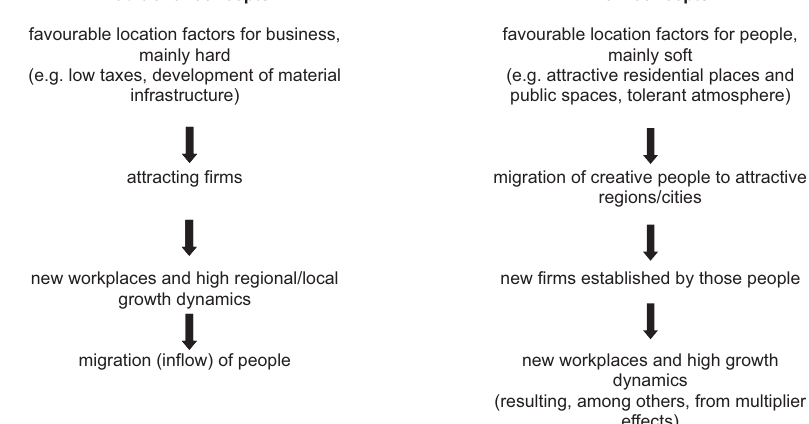
Fig. 1. Development paths of towns and regions in the traditional and the new economy. Source: Stryjakiewicz (2010).